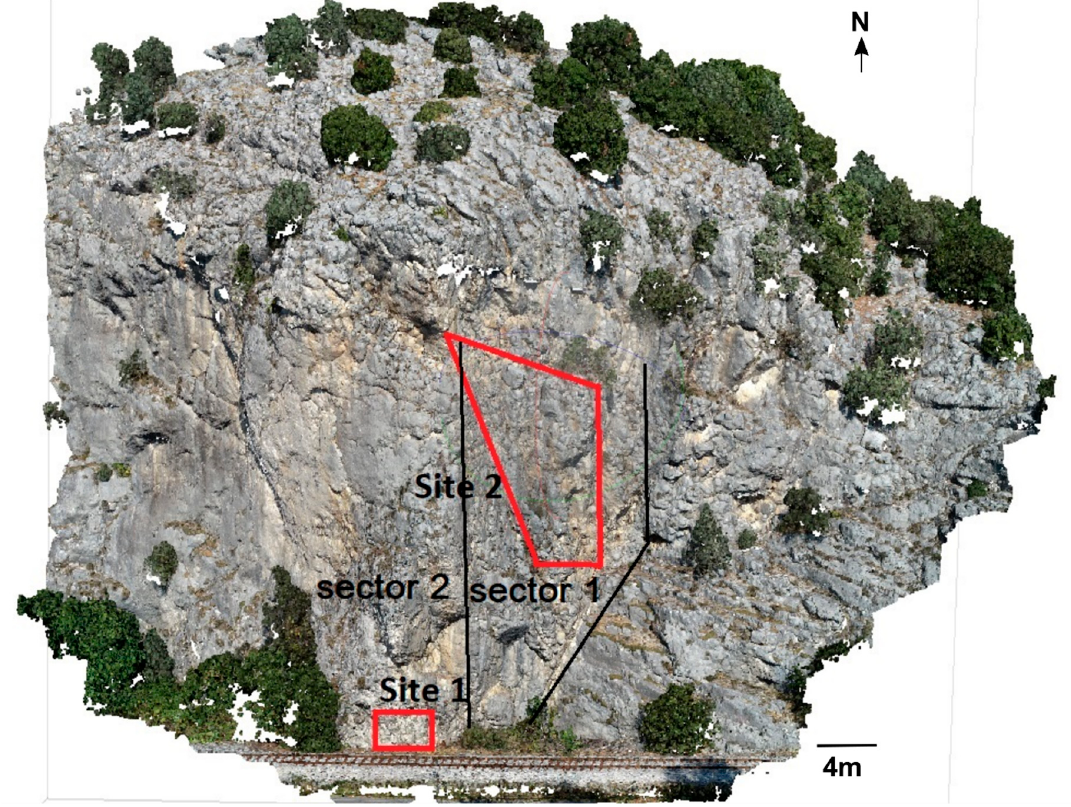
Figure 9. Sectors of the rock face colored based on the slope direction. Site 1 and 2 are also shown. Table 4. Evaluation of SMR parameters of the discontinuity sets and formed wedges at sector 1.